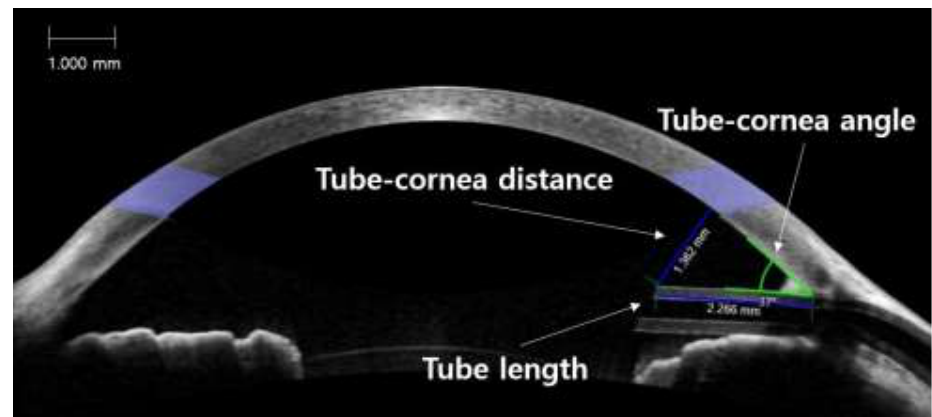
Figure 1. Anterior segment optical coherence tomography measurements of tube parameters: tube-cornea angle (TCA), tube-cornea distance (TCD), and tube length (TL).